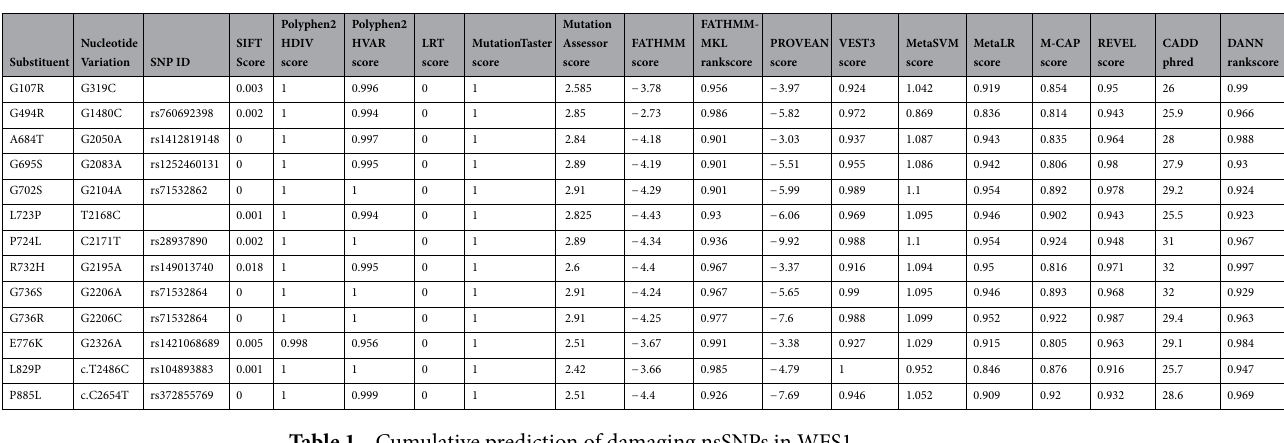
Table 1. Cumulative prediction of damaging nsSNPs in WFS1.